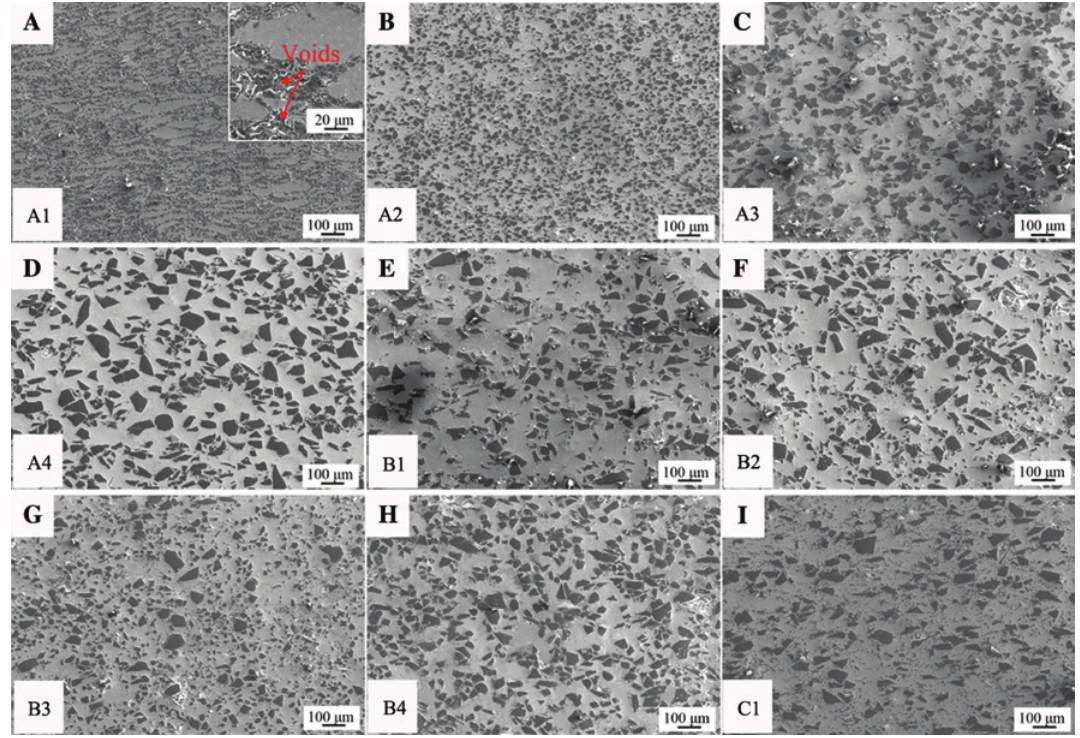
C particles in the inner layer of all BRALCs samples: (A) A1, (B) A2, (C) A3, (D) A4, (E) B1, (F) B2, (G) B3, (H) B4, Figure 4: The dispersion of B 4 and (I)